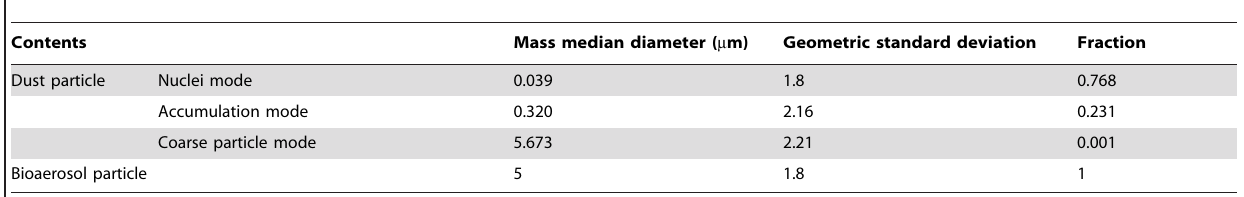
Table 1. Parameters of model particle distributions.